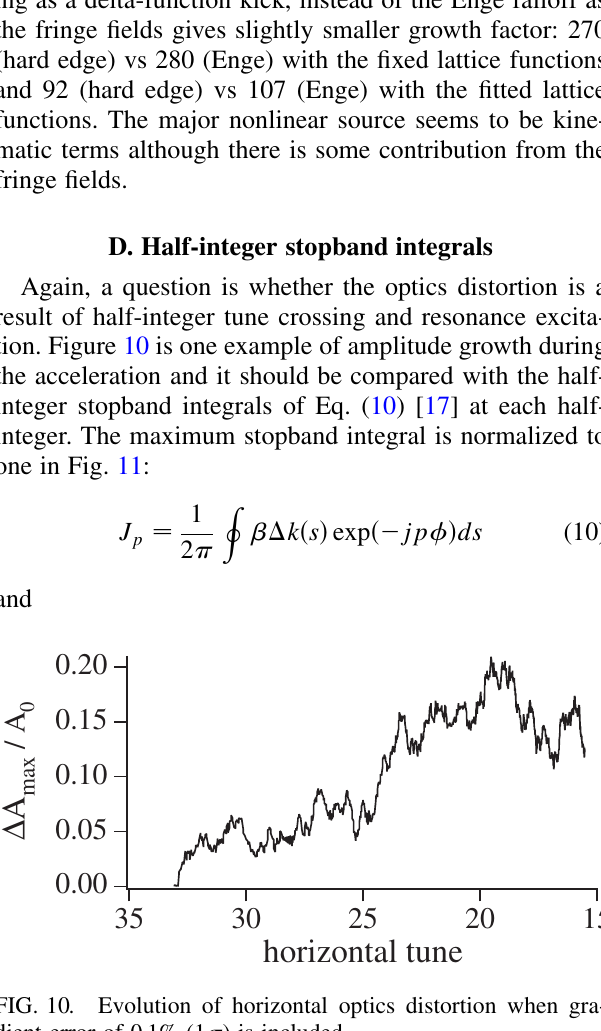
FIG. 10. Evolution of horizontal optics distortion when gra- dient error of 0.1% ( 1 (cid:5) ) is